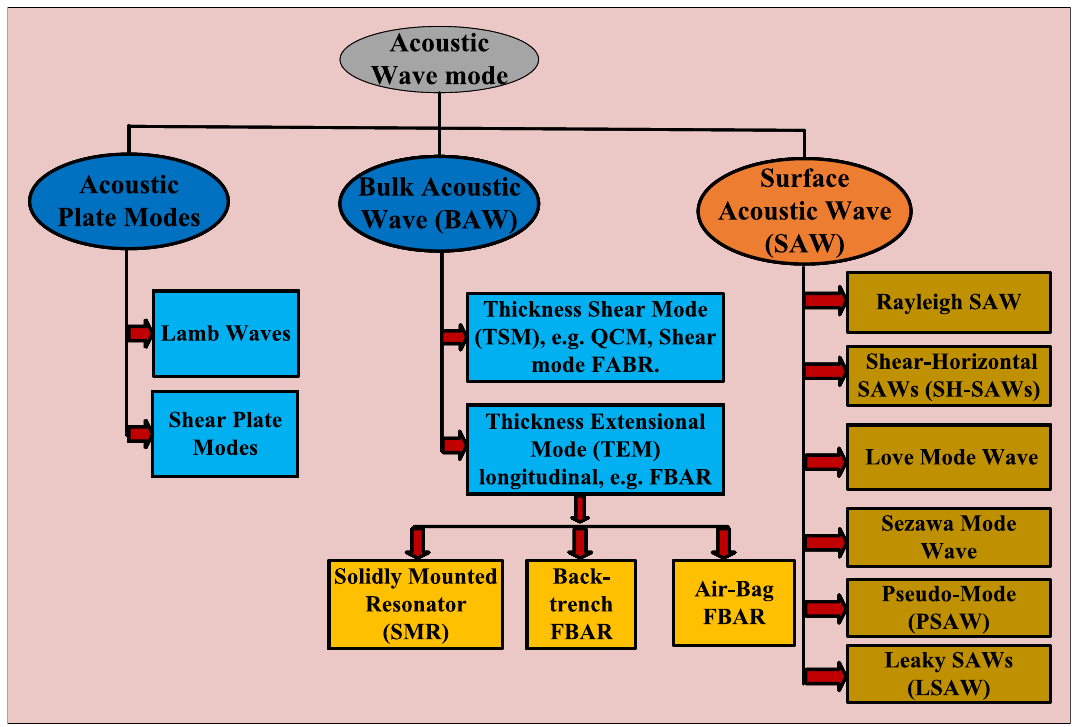
Fig. 3 Classification of different wave modes in two categories: surface and bulk acoustic wave (BAW) and surface acoustic waves